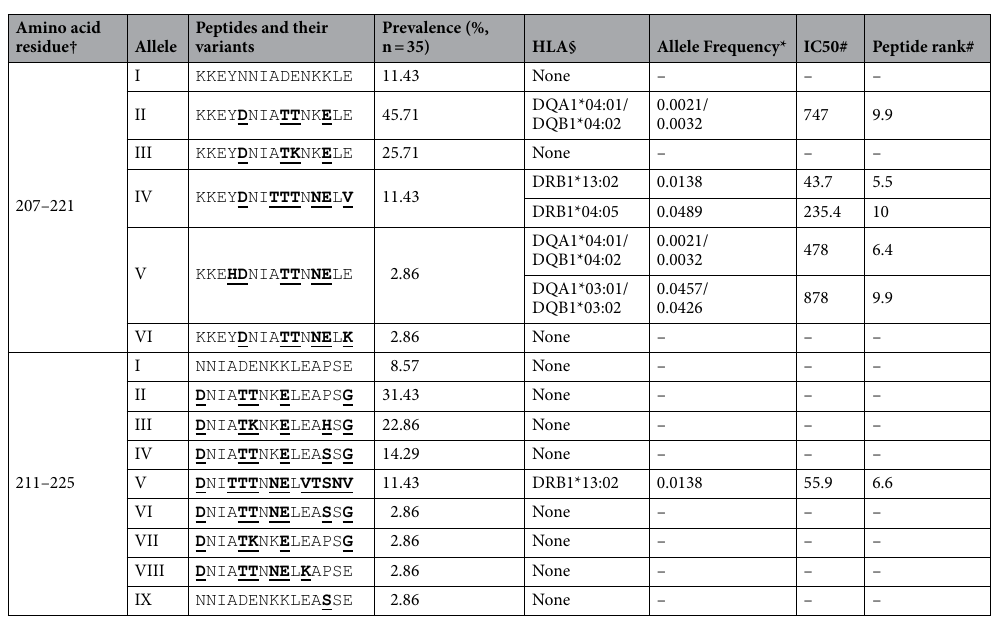
Table 6. Predicted HLA class-II binding peptides in block IV of PmMSP1 . † Positions and amino acid substitutions are based on the FJ824669 sequence. § Analysis based on the HLA alleles available in the IEDB analysis resource (accessed February 18, 2022). *Allele frequency among Thai population 44 . # Based on NN-align and the IEDB recommended 2.22 method 43